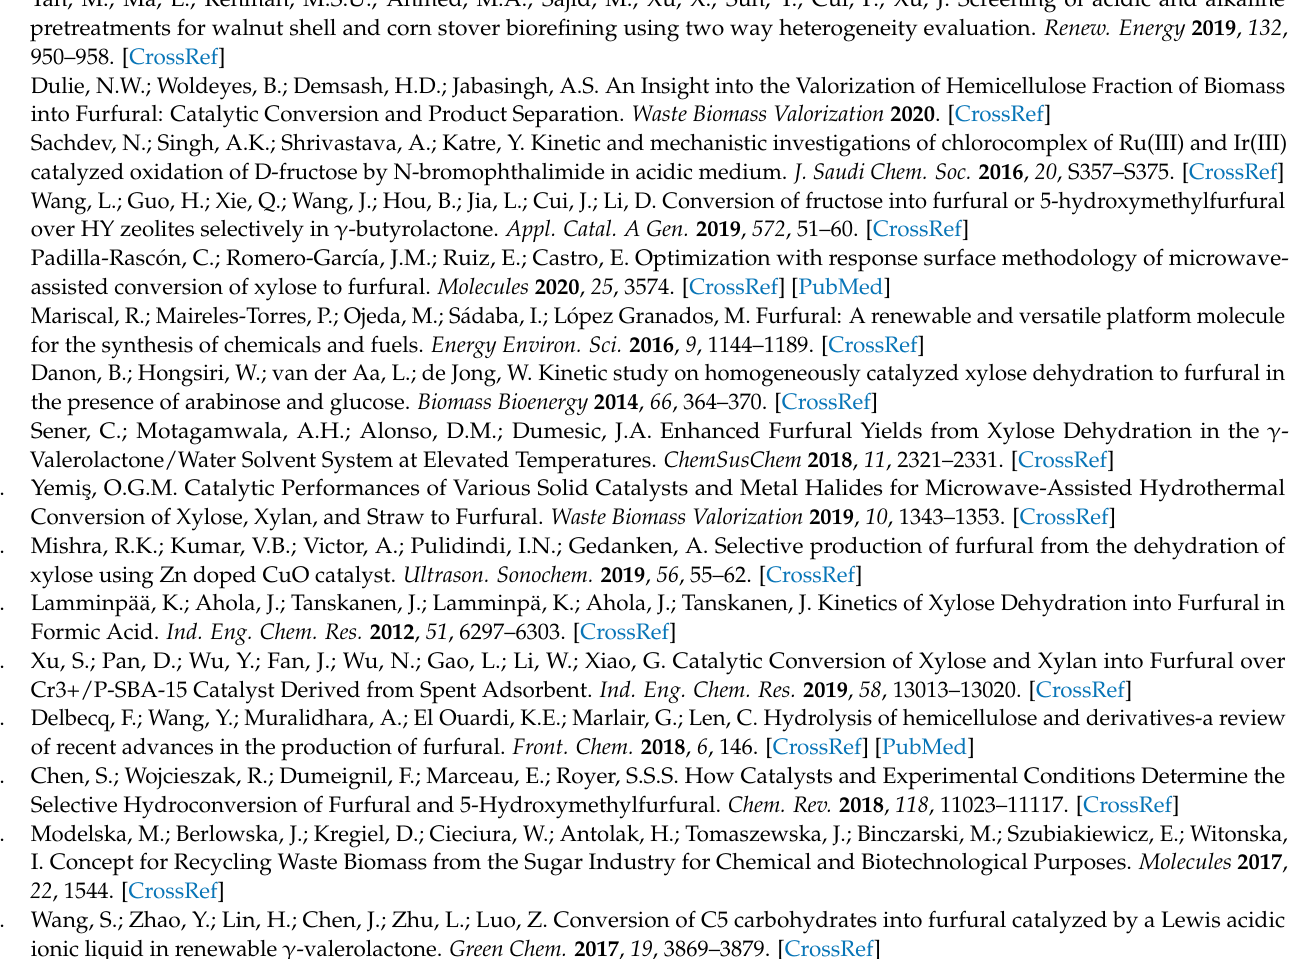
Figure S5. Kinetic plots of organic acid-catalyzed conversion of xylose into furfural in the DMSO solvent